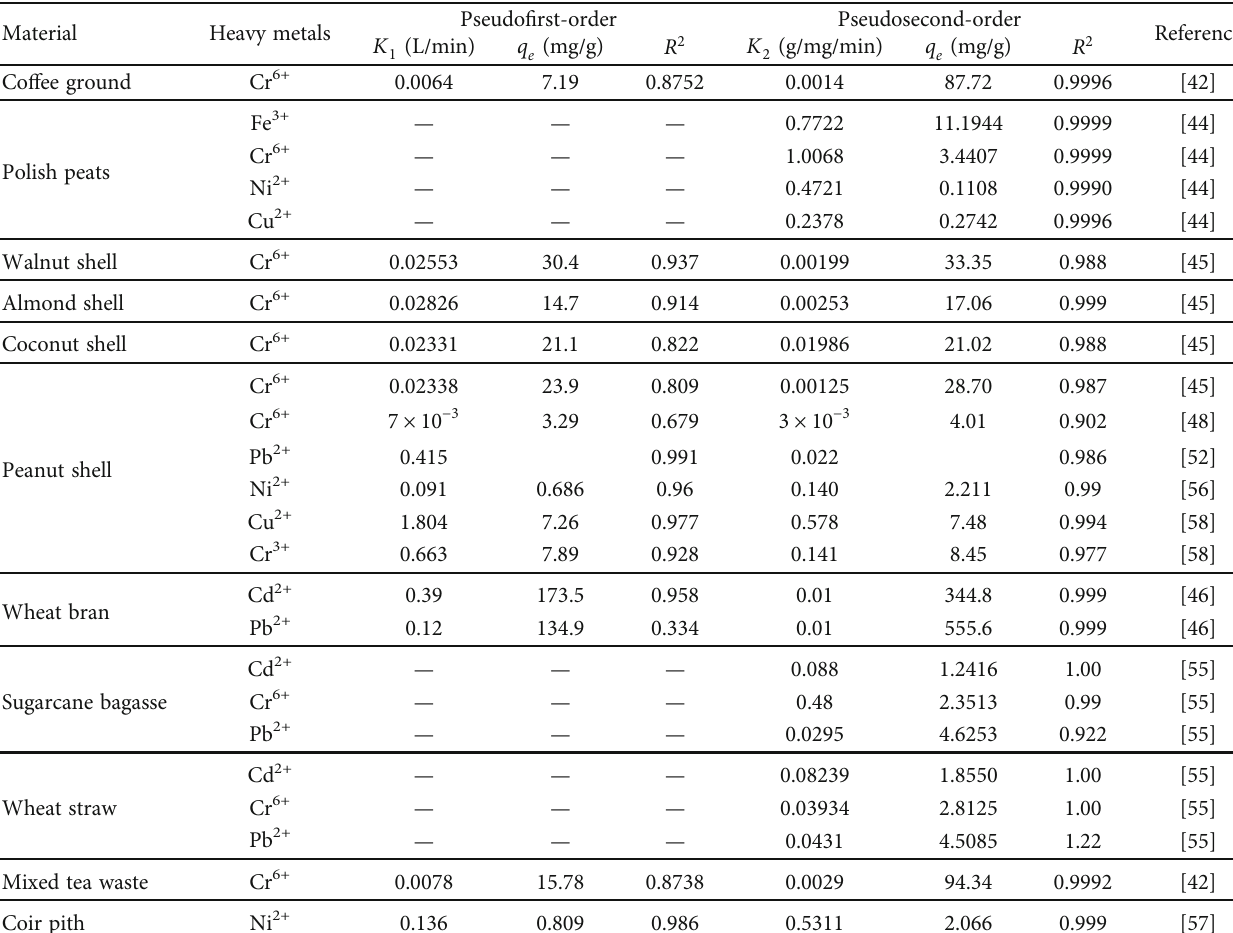
Table 6: Reported parameter values for pseudo fi rst- and pseudosecond-order kinetic models for heavy metal adsorption on various biomass-derived